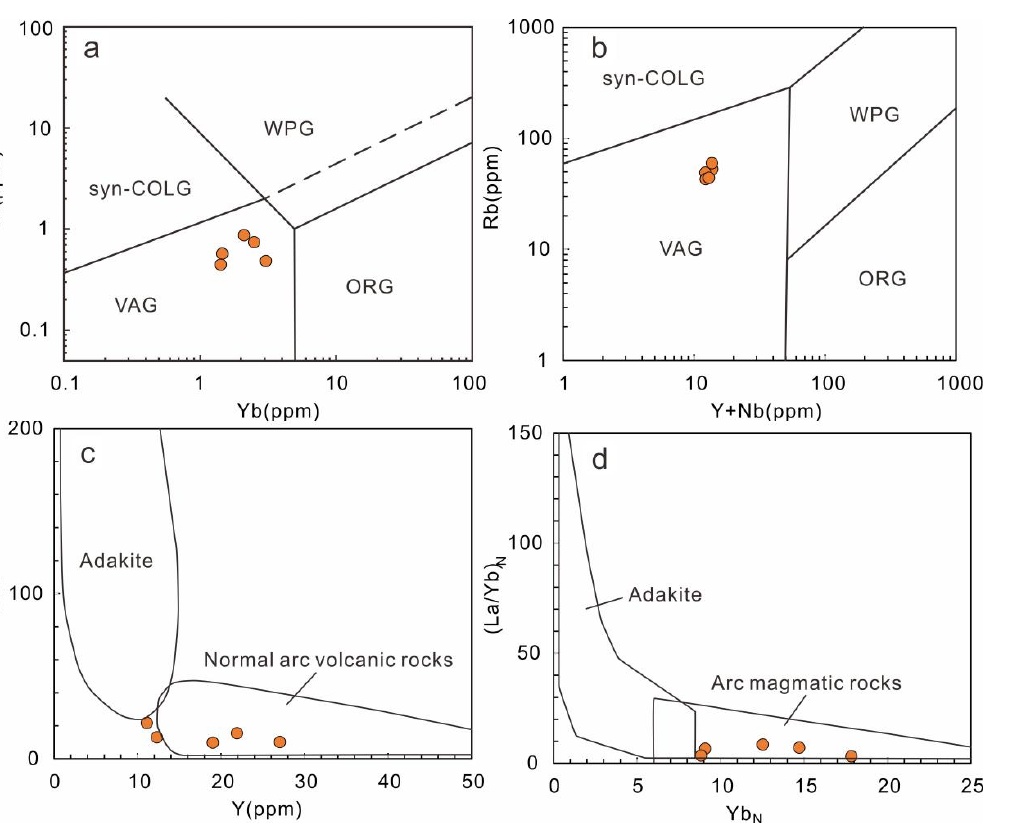
Figure 12. ( a ) Ta versus Yb diagram (after Pearce et al., 1984 [120]) ( b ) Rb versus Y+Nb diagram (after Whalen et al., 1987 [103]), ( c ) Sr/Y versus Y diagram (after Defant and Drummond, 1990 [121]), and ( d ) (La/Yb) N versus Yb N diagram (after Martin et al., 2005 [122]) for the granitic pebble samples. Abbreviations: syn-COLG, syn-collision granite; WPG, within plate granite; ORG, ocean ridge granite; VAG, volcanic arc granite.